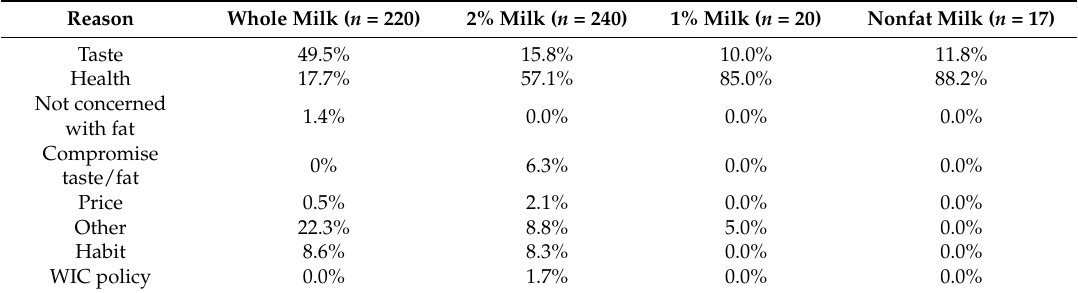
Table 2. Reason for Choosing Milk by Type